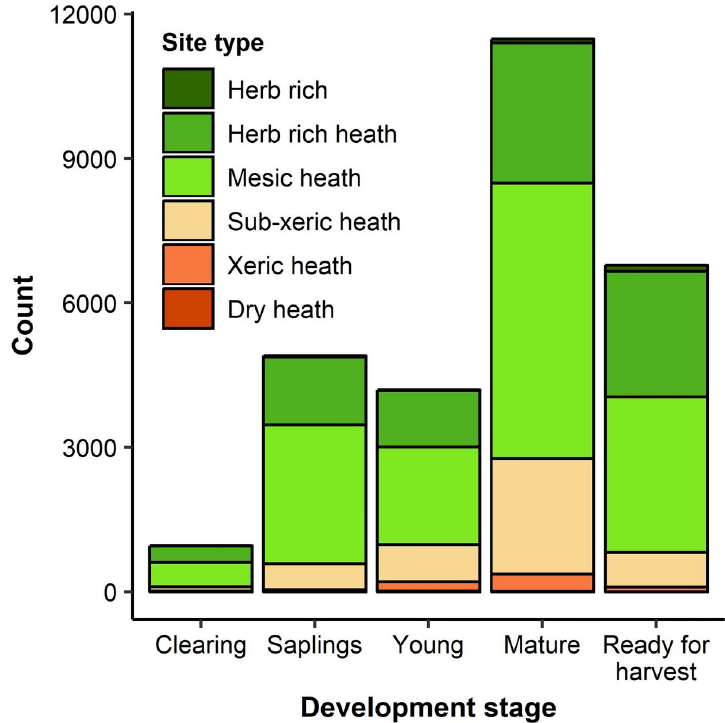
Fig 1. Characteristics of the stands comprising the study area. Distribution of the forest stands included in the study classified into present development stages (x axis) and site types (bar fill). The development stages and site types were defined in the forest inventories conducted by the Finnish Forest Centre. ‘Young’ stands have a mean diameter at breast height of 8–16 cm, and ‘Mature’ stands a mean diameter at breast height greater than 16 cm but are not yet ready for final harvest. ‘Ready for harvest’ stands are greater than 16 or 14 m in dominant height and at least greater than 70 or 90 years in age, as defined in the current Finnish recommendations for the timing of final felling [35]. Site types are presented according to the Finnish forest classification system [36] and range from fertile mixed-species stands (herb rich) to less fertile, pine-dominated stands (dry heath).